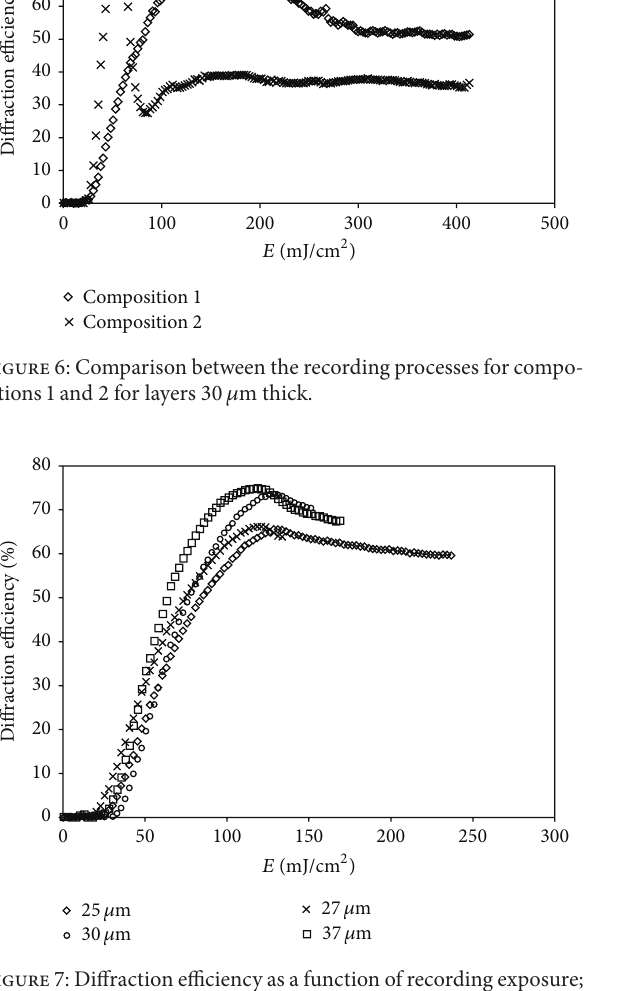
Figure 7: Diffraction efficiency as a function of recording exposure; sample thickness between 25 and 37 𝜇 m using composition 3.